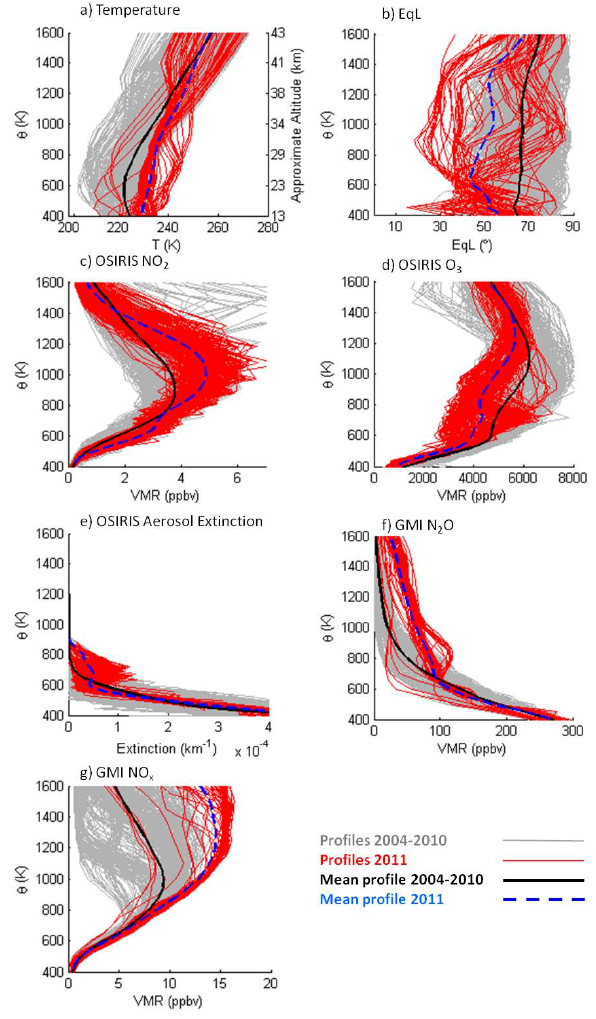
Fig. 2. Profiles of meteorological fields and composition above PEARL for 1 April to 31 May. Thin grey and thick black lines indi- cate individual profiles and average profiles, respectively for 2004– 2010. Thin red lines and thick blue dashed lines indicate individual profiles and average profiles, respectively for 2011. (a) Temperature (K) and (b) EqL ( ◦ ) from GEOS-5 DMPs at 12:00 UTC above Eu- reka. (c) NO 2 VMR (parts per billion by volume – ppbv), (d) ozone VMR (ppbv), and (e) aerosol extinction (km − 1 ) from OSIRIS mea- surements within 500 km of Eureka. (f) N 2 O VMR (ppbv) and (g) NO x VMR (ppbv) from GMI daily profiles above Eureka. The ap- proximate altitude corresponding to the potential temperature levels is shown in the y-axis of (a)